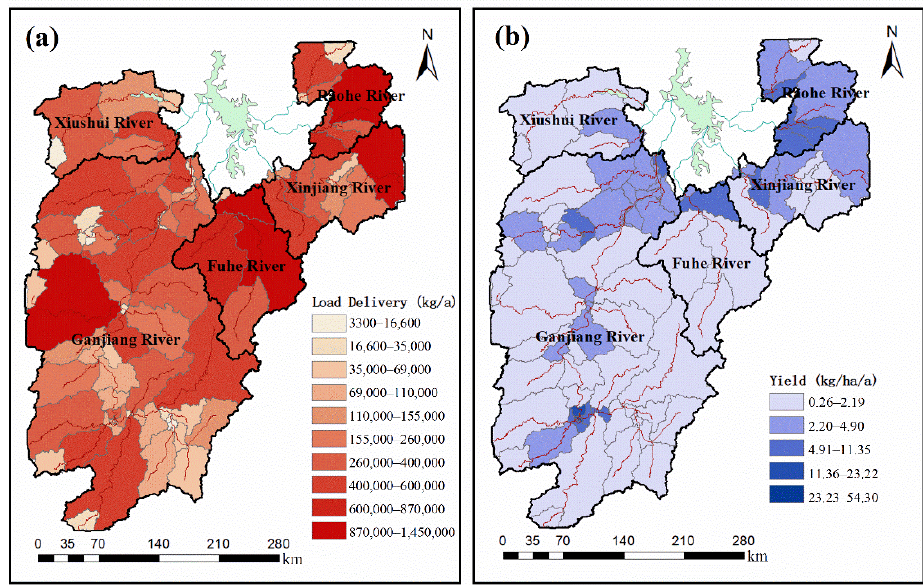
Figure 9. ( a ) Loads and ( b ) yields of NH 4+ -N delivered to the target outlets in PLB.